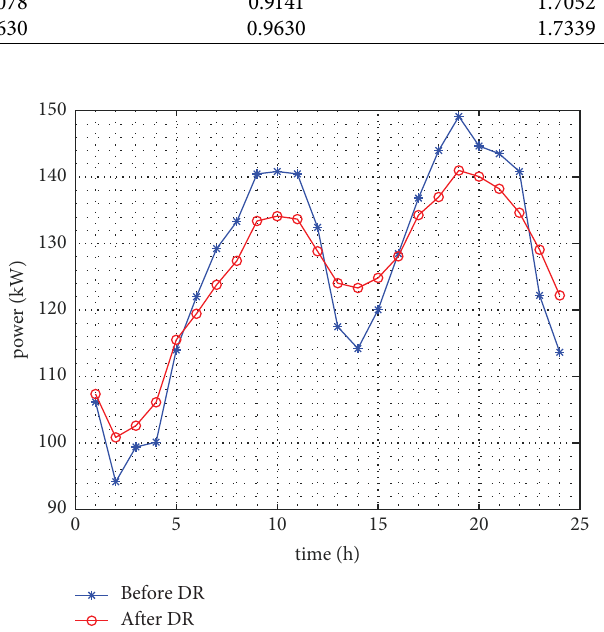
Figure 3: Comparison of electricity load before and after DR. Table 4: Specifc parameters of the generator